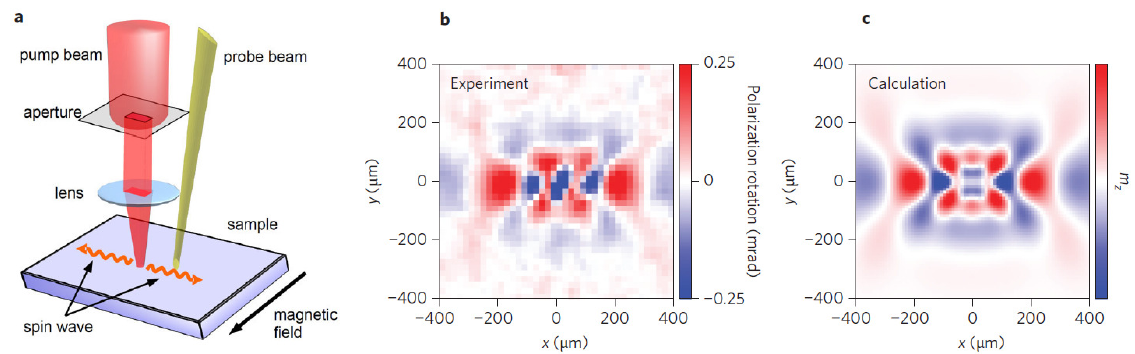
Figure 11. ( a ) Experimental configuration for directional control of spin wave emission; ( b ) Two-dimensional spin waveforms obtained by ( b ) Experiment and ( c )